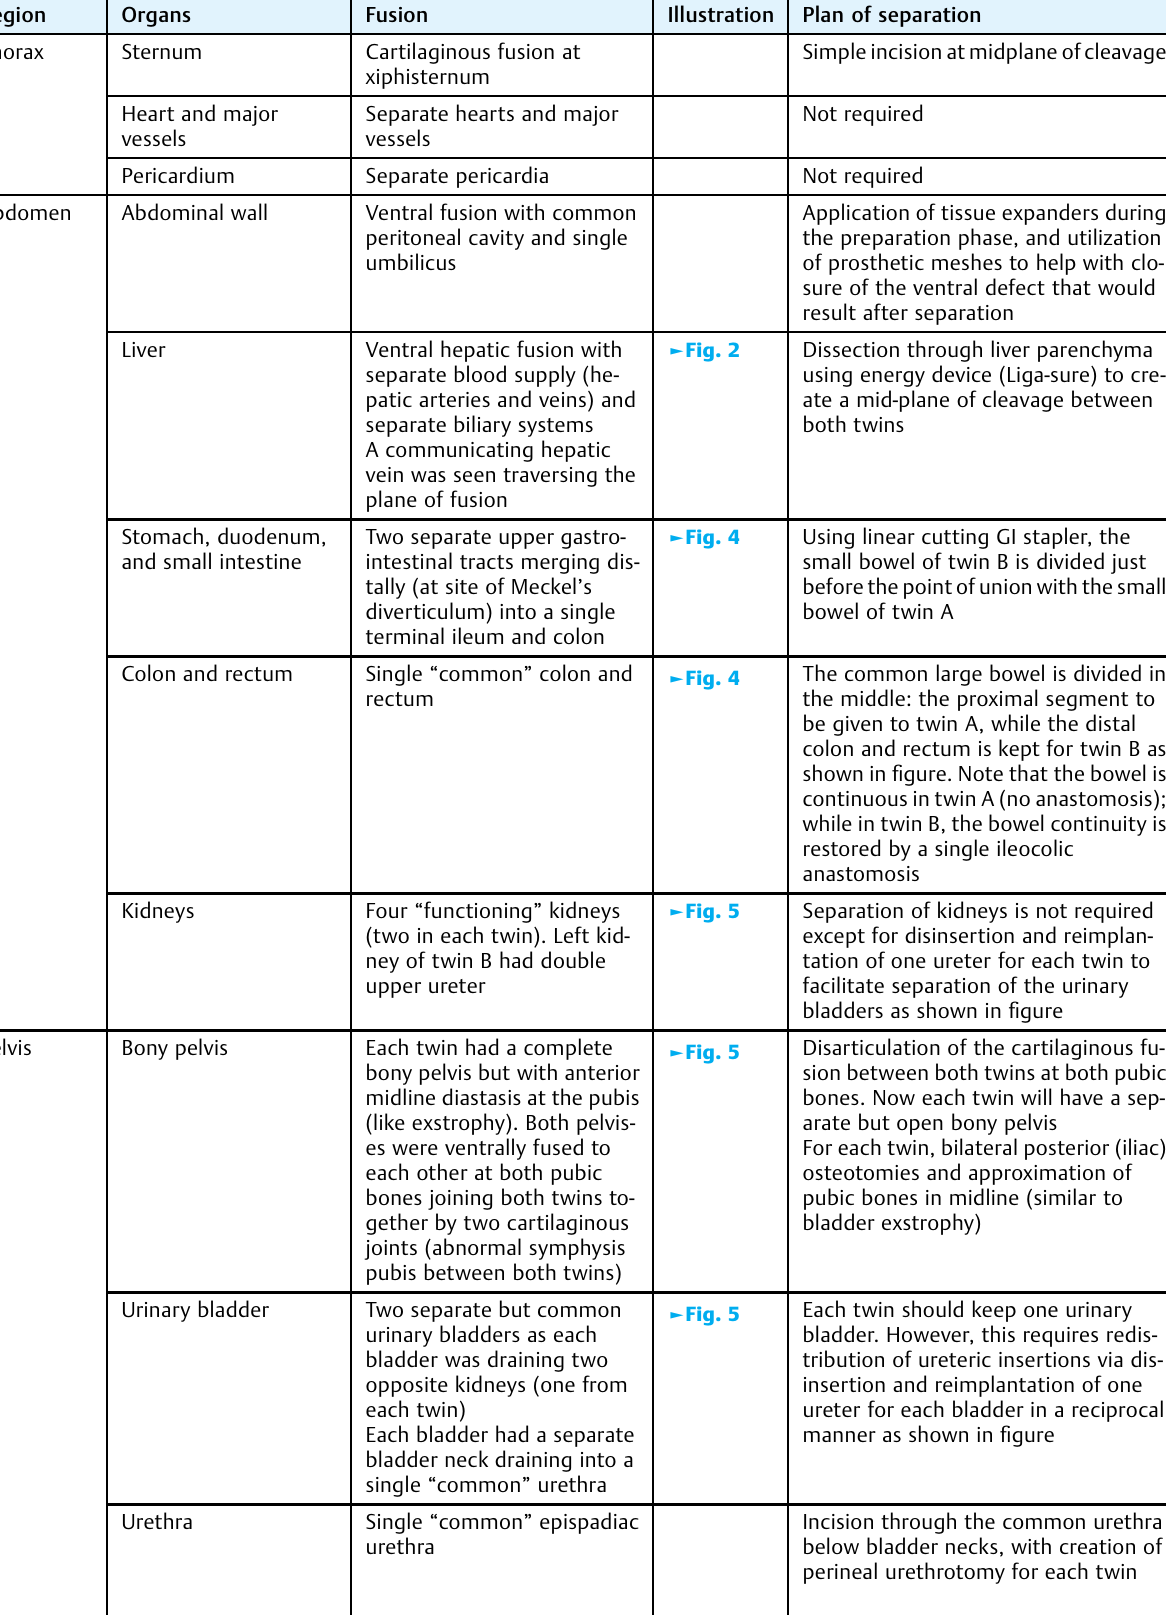
Table 1 Summary for preoperative imaging fi ndings (areas of fusion between both twins) and the corresponding plan of separation for each region Region Illustration